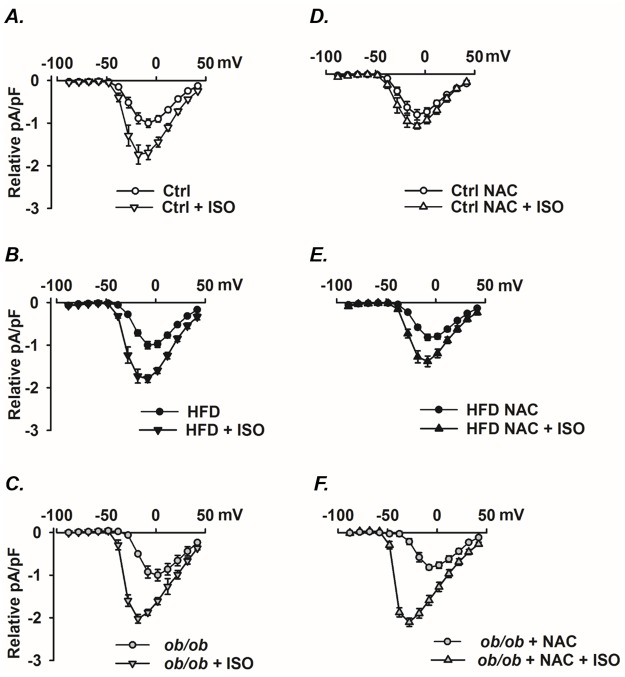
The ISO-induced increases in L-type Ca2+ current density is ROS-independent in cardiomyocytes with the metabolic syndrome.Mean data (±SEM; n = 6–8 in each group) of I-V curves of peak current density in the absence and presence of ISO (100nM) and NAC (20 mM) as indicated from control (A, D), HFD (B, E) and ob/ob
(C, F) cardiomyocytes. The I-V relationships were obtained by giving test pulses varying from -80 mV to +50 mV from a holding potential of -80 mV. The mean basal current density (i.e. in the absence of NAC and ISO) was -6.1±0.5 pA/pF and for comparisons between groups each group were normalized its basal current to give a relative current density (relative pA/pF).